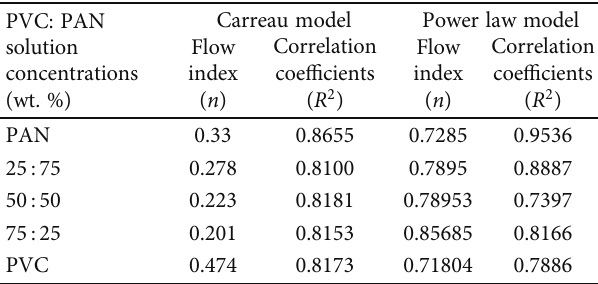
Table 1: Results of fl ow index ( n ) according to Carreau and power law models for pure polymers and PVC: PAN blends according to Equations (2) and (4)